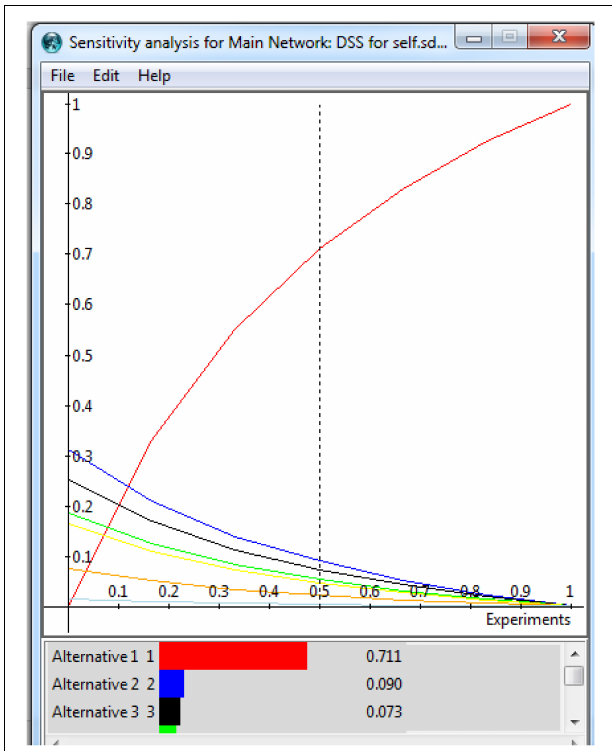
FIGURE 5 | Analytic hierarchy process (AHP) sensitivity. Permission to reproduce images of Super Decisions has been given by Creative Decisions Foundation.